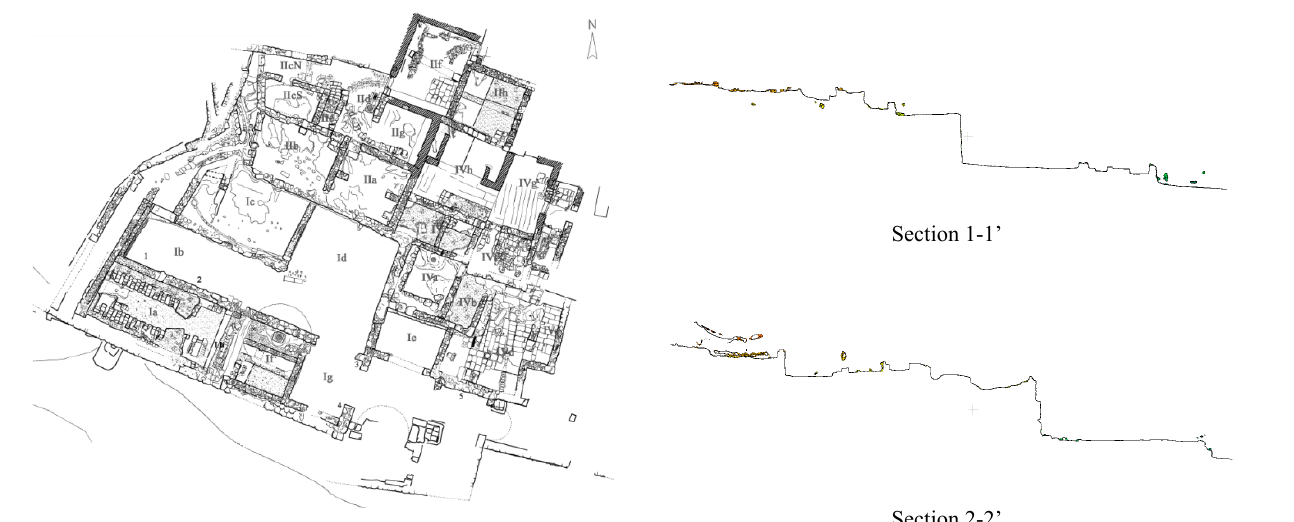
Figure 15. Cross sections extracted from the 3D model (rough direction: north-east / south-west)